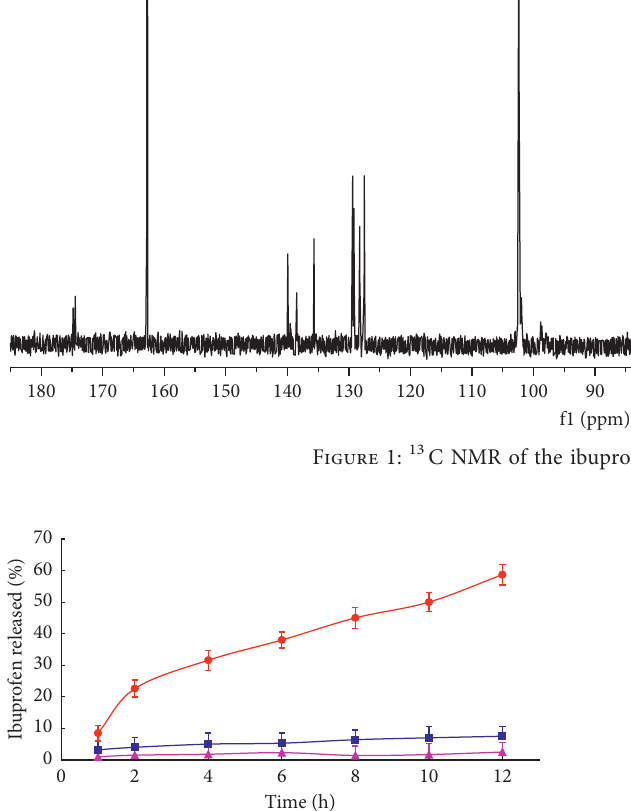
Figure 2: Release profile of the ibuprofen- β -CyD-PEG conjugate incubated in rat gastrointestinal tract contents at 37 ° C. Each data represent the mean ± SEM. 1. Stomach contents ( ▲ ); 2. Small intestine contents ( ■ ); 3. Colonic contents ( ● ).